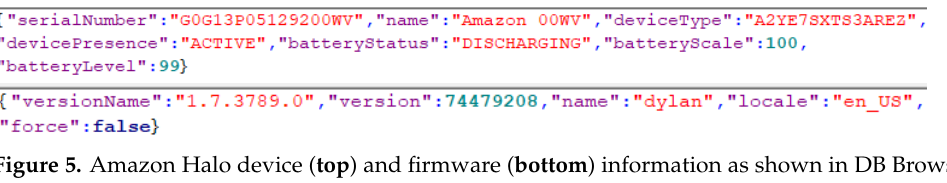
Figure 5. Amazon Halo device ( top ) and firmware ( bottom ) information as shown in DB Browser for SQLite.